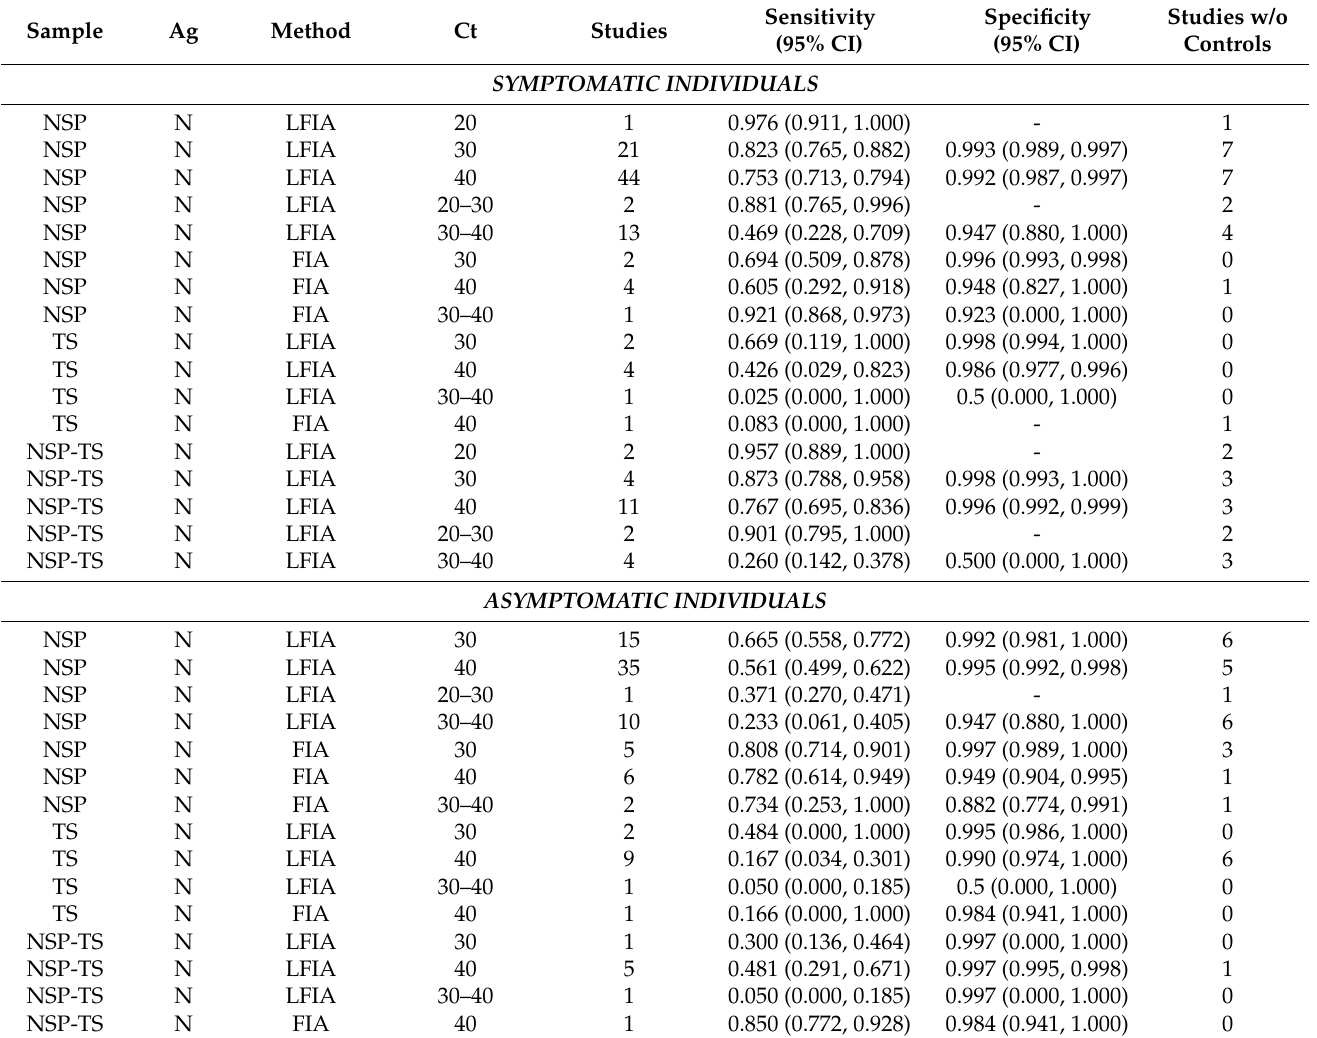
Table 4. Results of the meta-analysis for the different types of assays for symptomatic and asymp- tomatic patients. Listed information includes the pooled sensitivity and specificity along with the 95% confidence intervals. (NSP: pharyngeal, nasopharyngeal, nasal specimens, TS: throat, saliva, N: nucleocapsid protein, S: spike protein, NS: nucleocapsid and Spike